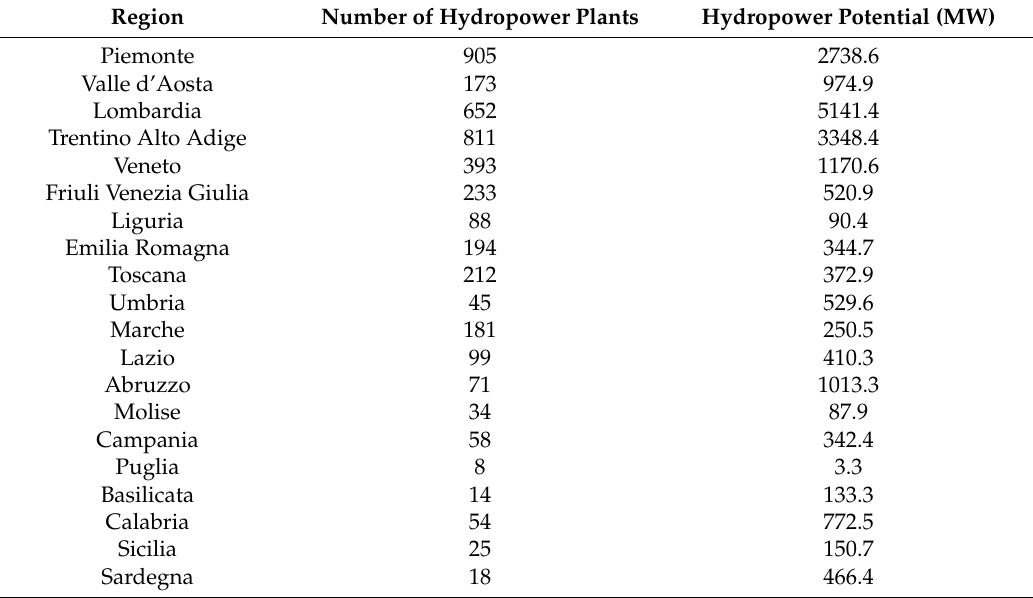
Table 1. Number and hydropower plants capacity in the Italian regions (source